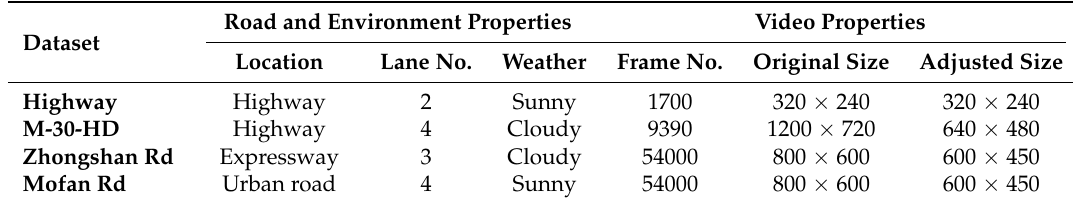
Table 2. The attributes of the